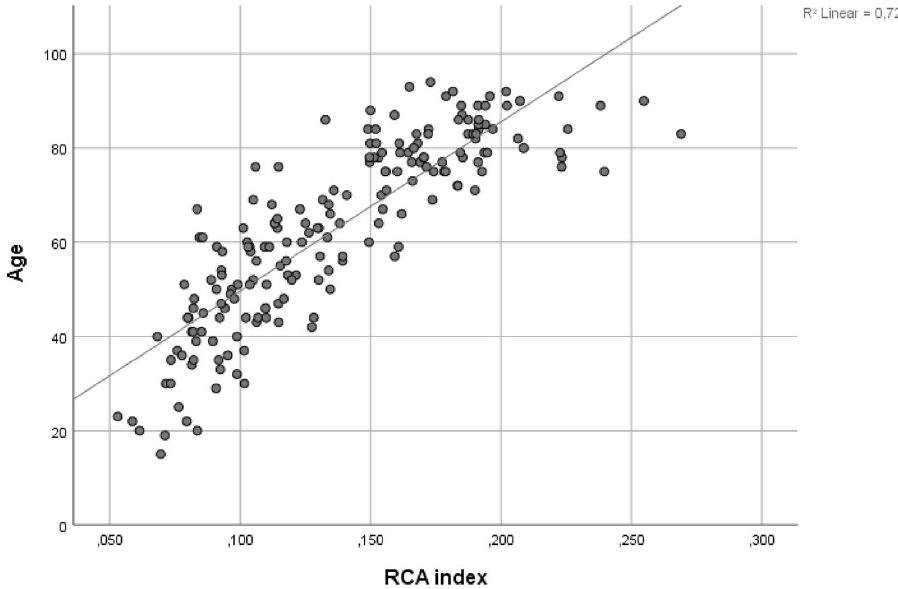
Figure 3. Age curve for RCA index.